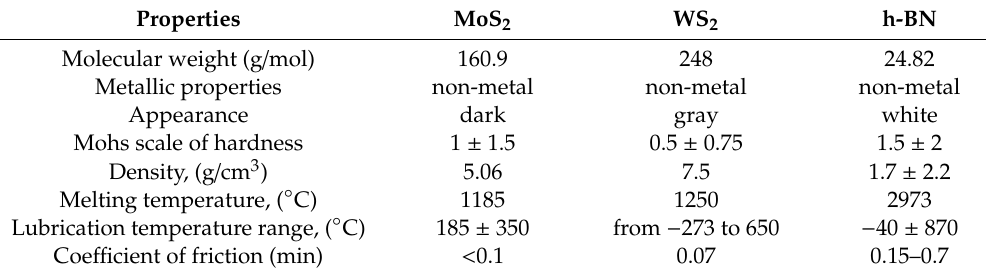
Table 2. Layered